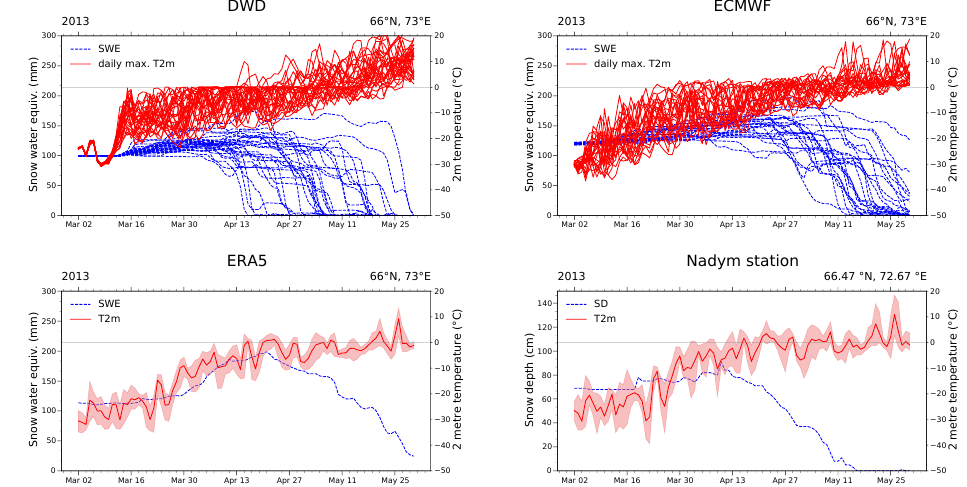
Figure 6. Top : daily snow water equivalent (blue) and daily maximum 2-m temperature (red) for each ensemble member of DWD and ECMWF. Bottom : daily snow (blue), daily mean temperature (red line), and daily min/max temperature (red area) from ERA5 and Nadym station (snow given as snow depth). At the stations, the snowmelt duration (from the maximum to one-third) lasts slightly more than one month, which is shown in Figure 7 at the bottom of each sub-figure.